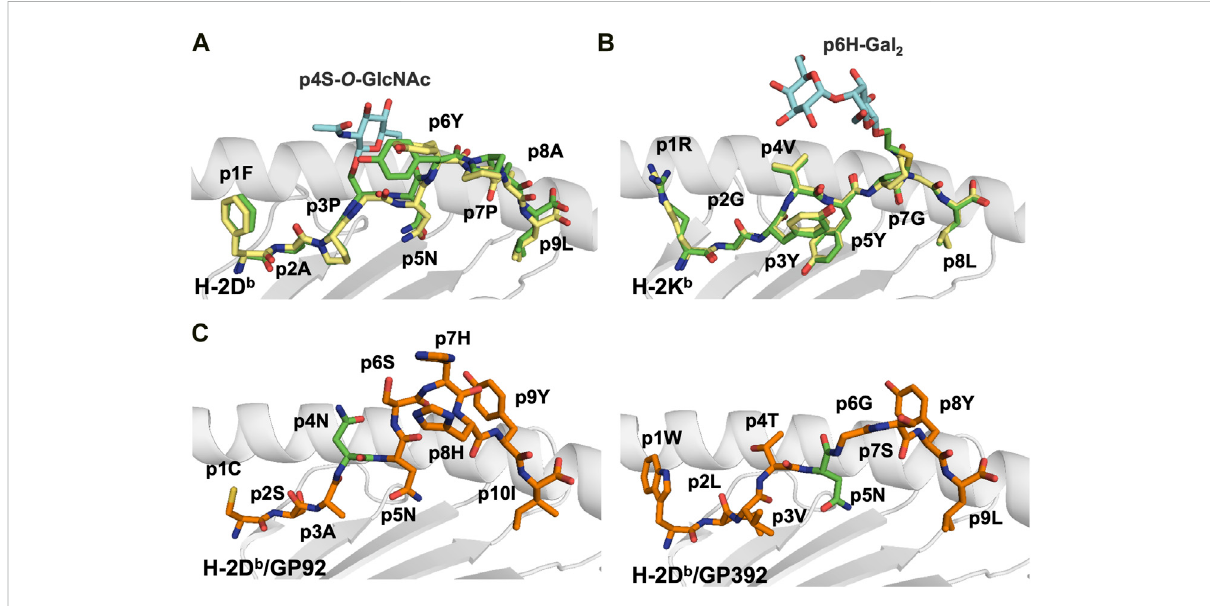
FIGURE 2 Glycosylation occurs most often in the middle section of the peptide creating a neoantigen that can break tolerance and select for different T cell repertoires (A) . Comparative analyses of the crystal structures of H-2D b in complex with the immunodominant Sendai virus epitope FAPGNYPAL (1CE6. pdb) colored in yellow and with the glycopeptide analog K2G with a glycan at p4 (1QLF.pdb), colored in green) (Glithero et al., 1999) reveal the similarity of the peptide backbones. In contrast, the protruding glycan moiety (in blue) may impair/modulate TCR recognition (B) . Comparison of the crystal structures of H-2K b in complex with the vesicular stomatitis virus (epitope RGYVYQGL (2VAA.pdb, in yellow) (Fremont et al., 1992) and the glycosylated RGY8-6H-Gal2 (1KBG.pdb, in green) (Speir et al., 1999) demonstrates their high conformational similarities. In contrast, the central region of the putative TCR binding site is dominated by the extensive exposure of the tethered carbohydrate (colored in blue), which forms a neoantigen. (C) . Glycosylation of MHC-I-restricted peptides can be used by pathogens to either impair TCR recognition of speci fi c epitopes or reduce the overall stability of pMHC complexes. This is exempli fi ed by the crystal structures of the LCMV epitopes GP92 and GP392 in complex with H-2D b . While glycosylation of the asparagine residue at peptide position 4 in GP92 (5JWE.pdb, in green) may impair TCR